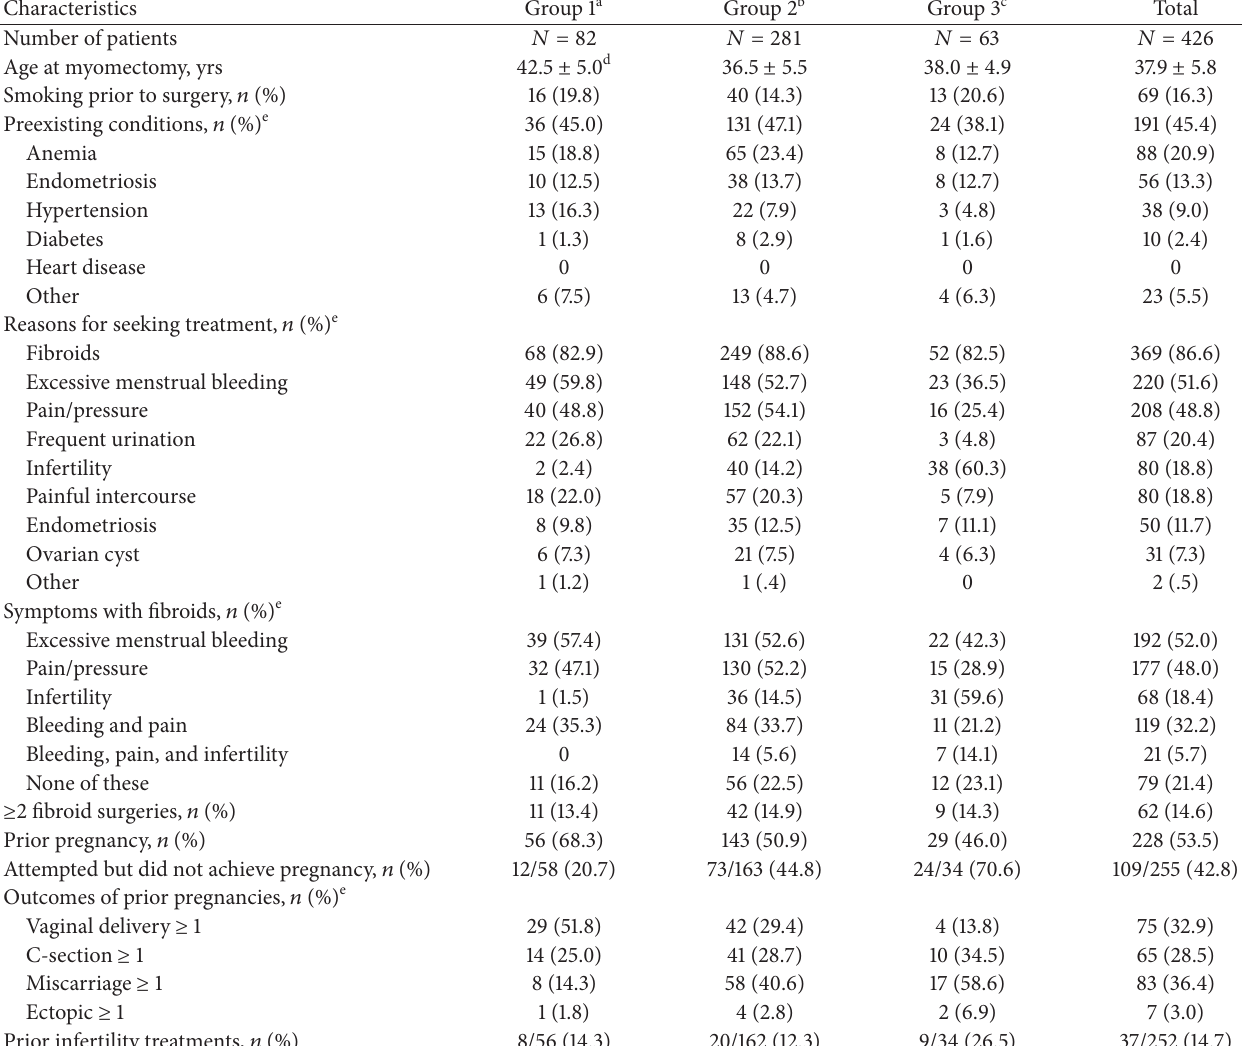
Table 1: Patient characteristics at